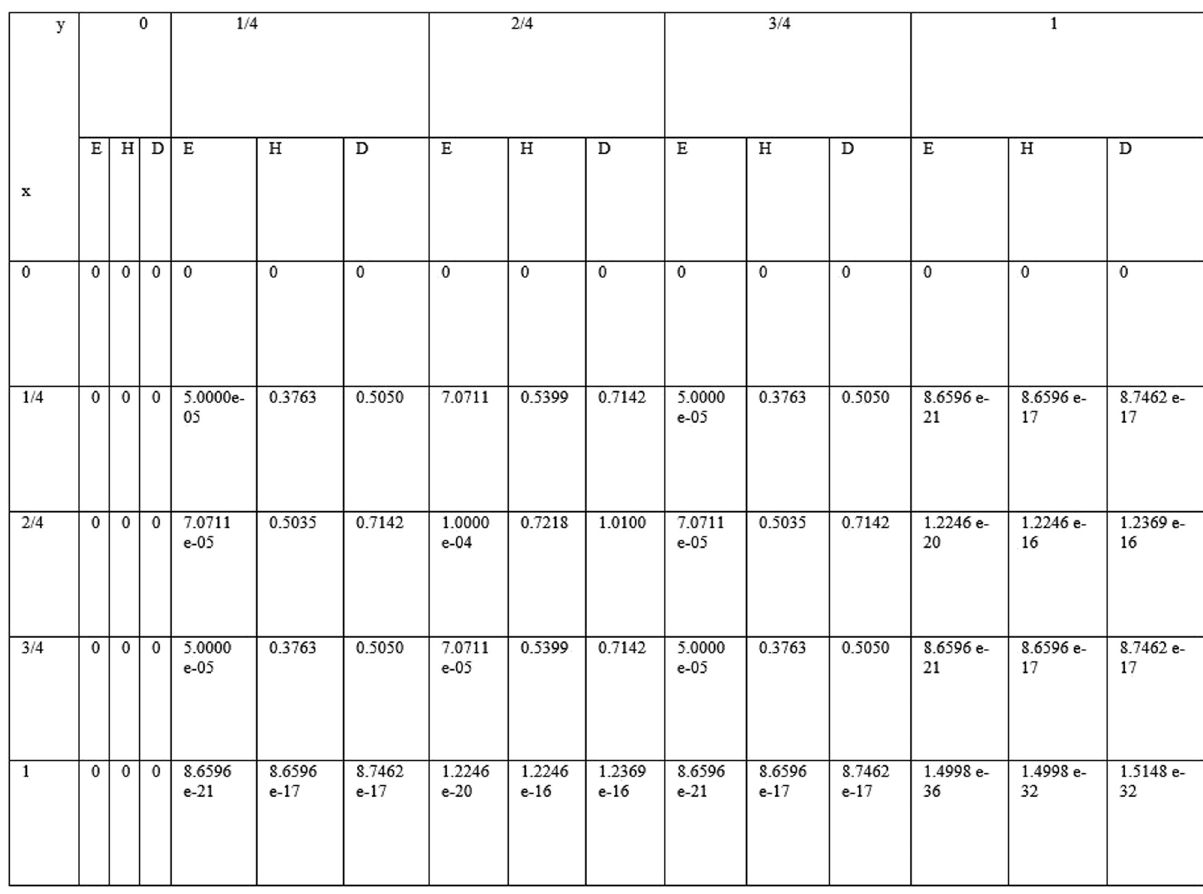
Figure 4: Comparison of exact and approximate solution of di ff usion equation in Example 4.2 with ρ = 0.4, T 0.01 = on a 5 5 ∗ mesh, where E ⇒ exact solution, H ⇒ solution by the hybrid D ( TQ ) M, D ⇒ solution by the